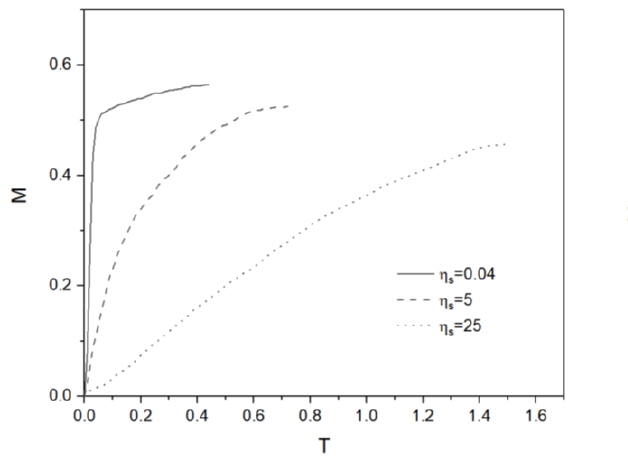
Figure 4. ( a ) Droplet migration for different s  . ( b ) Droplet migration for different